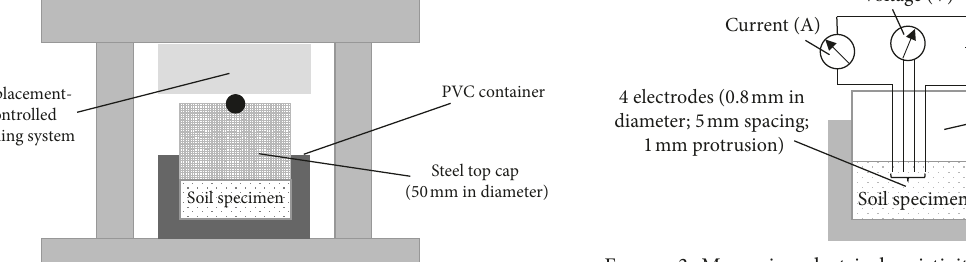
Figure 3: Measuring electrical resistivity using the Wenner four- electrode method.